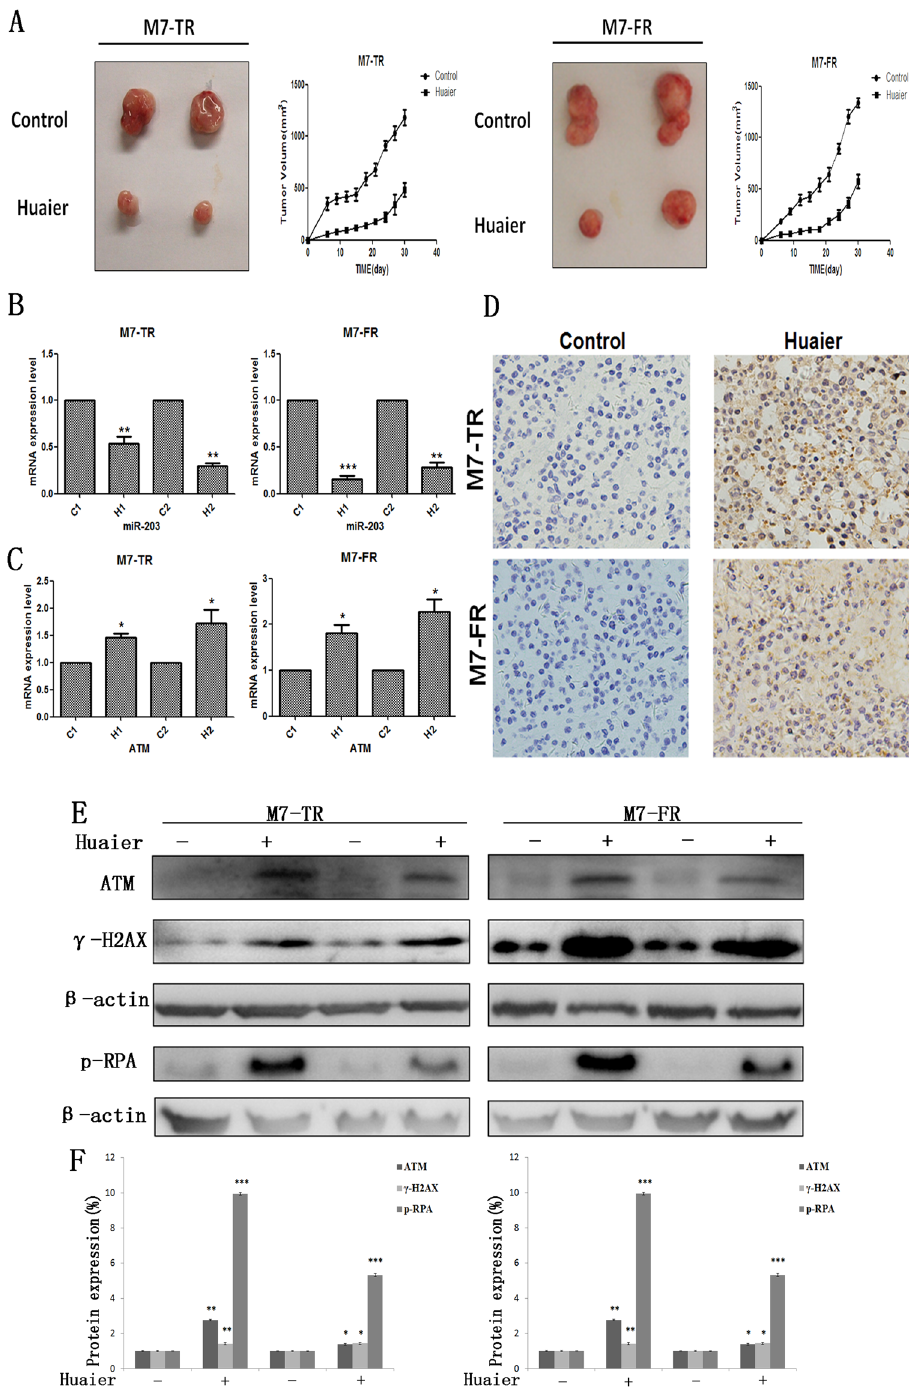
Figure 6. Huaier extract enhanced the suppression of tumourigenesis in a xenograft model. ( A ) Flank tumours were established in BALB/c nu/nu female mice, as described in the Materials and Methods section. The mice were sacrificed 40 days after flank injection; representative tumours are shown. Growth curves of xenograft tumours after injection of M7-TR and M7-FR cells. The miR-203 ( B ) and ATM ( C ) expression levels after treatment or not with Huaier extract. ( D ) Immunohistochemical analysis of ATM. ( E and F ) The protein changes of ATM, γ -H2AX and p-RPA after treatment with Huaier extract, compared to the control group. * P < 0.05 or ** P < 0.01 compared with the controls. The data are presented as the mean ± SD of three separate